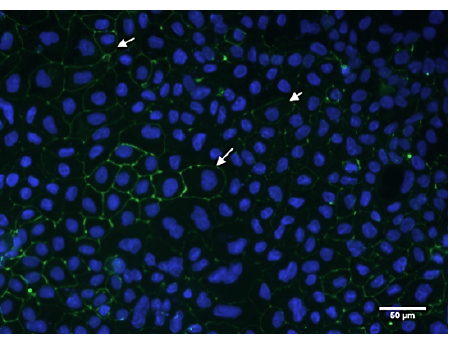
Figure 5. Immunofluorescence of differentiating human Caco-2 cells. Green fluorescence indicates ZO-1 (white arrow) and blue fluorescence indicates nuclei of cells. Scale bar: 50 µ m.